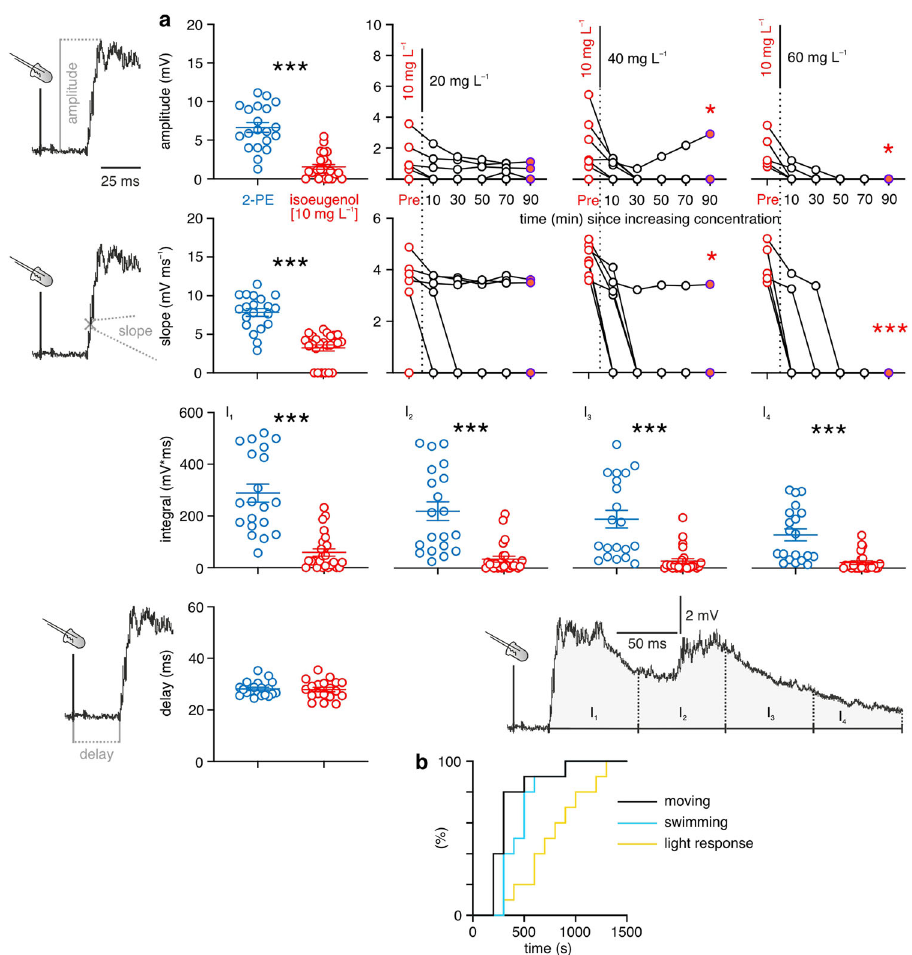
Fig. 4 Isoeugenol massively affects visual inputs into the Mauthner neuron. a Anesthetizing fi sh with 10 mg L − 1 isoeugenol affected all aspects of the visual PSP ( n = 25; red circles indicate individual fi sh), as seen by comparison with 2-PE anesthetized control fi sh ( n = 20; blue circles), except delay. Measured parameters (amplitude, slope, integrals, delay) are illustrated. Means ± standard errors of mean are indicated. PSP peak amplitude and slope were reduced further when isoeugenol concentration was increased to 20, 40, or 60 mg L − 1 . Note absence of detectable visual PSPs in many fi sh (individual circles, connected by lines). Diagrams and fi sh as in Fig. 2. Signi fi cant differences between values obtained before the increase in isoeugenol concentration (Pre; red circles) and values obtained 90 min after the increase in concentration (orange fi lled circles) are indicated by red asterisks. One, two, three asterisks indicate P ≤ 0.05, P ≤ 0.01 or P ≤ 0.001, respectively. Connected circles indicate mean values of individual fi sh. b Recovery of vision in 10 fi sh that had been anesthetized with 20 mg L − 1 isoeugenol for 30 min. Percentage of fi sh showing the three indicated behaviors after absence (at time = 0 min) of anesthetic.